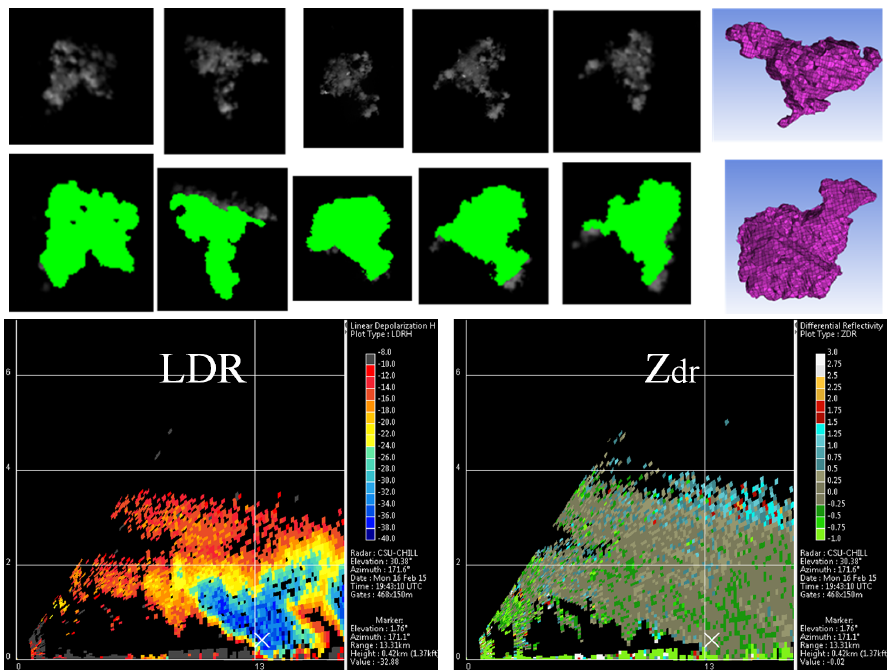
Figure 23. Some more illustrative results of MoM-SIE scattering calculations based on the MASC images captured during the 16 February 2015 event, in comparison with CSU-CHILL radar RHI plots at the same time. Results: MASC/MoM-SIE: ε r = 1.19 − j0.0002, LDR = − 24.5 dB, Z dr = − 0.05 dB; CHILL Radar: LDR = − 33 dB, Z dr = − 0.02 dB (12.92-km range).